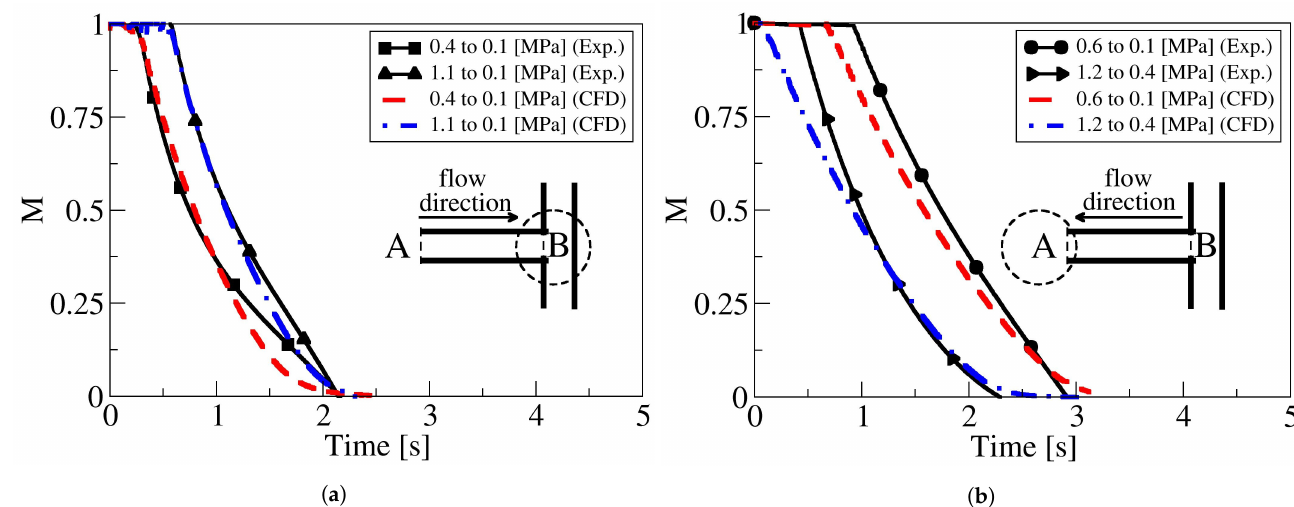
Figure 9. Temporal evolution of the maximum Mach number obtained at the nozzle separating the two reservoirs. Comparison between the numerical results and the experimentally-based ones. ( a ) Flow from large to small reservoir. ( b ) Flow from small to large